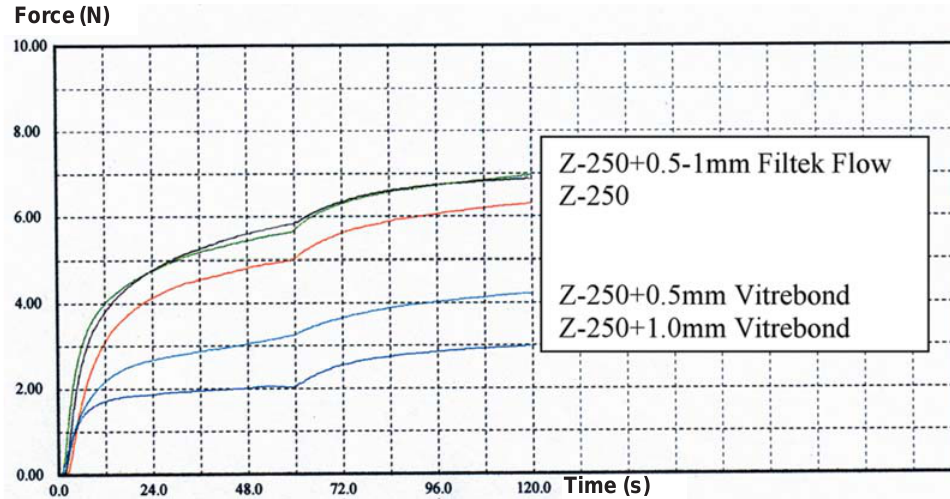
FIGURE 1- Force/time graph obtained for Z-250 composite resin without intermediate layer, with 0.5-mm-thick and 1-mm- thick Filtek Flow layer and with 0.5-mm-thick and 1-mm-thick Vitrebond